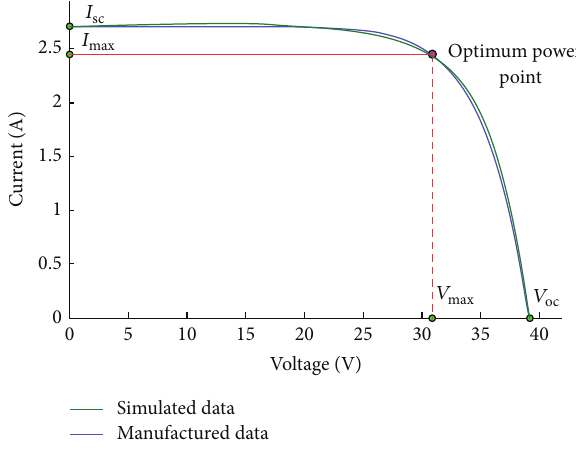
Figure 2: Typical I-V characteristic curve of a PV